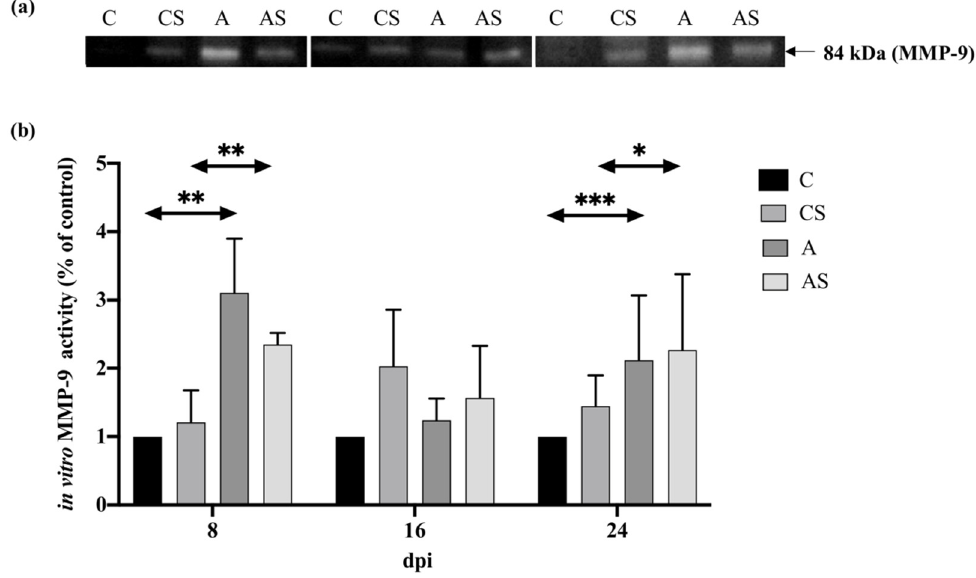
Figure 6. Activity of matrix metalloproteinases-9 (MMP-9) in the kidneys of mice infected with Acanthamoeba spp. MMP-9 was determined using zymography. Representative zymography ( a ) and densitometric analysis of MMP-9 protein ( b ) in mouse kidneys were shown. Data represent the means ± standard deviation for six independent experiments. (A: Immunocompetent mice infected with Acanthamoeba spp.; AS: Immunosuppressed mice infected with Acanthamoeba spp.; dpi: Days post Acanthamoeba spp. infection; C: Immunocompetent mice uninfected with Acanthamoeba spp.; CS: Immunosuppressed mice uninfected with Acanthamoeba spp.; statistically significant differences * p < 0.05; ** p < 0.01; *** p < 0.001).